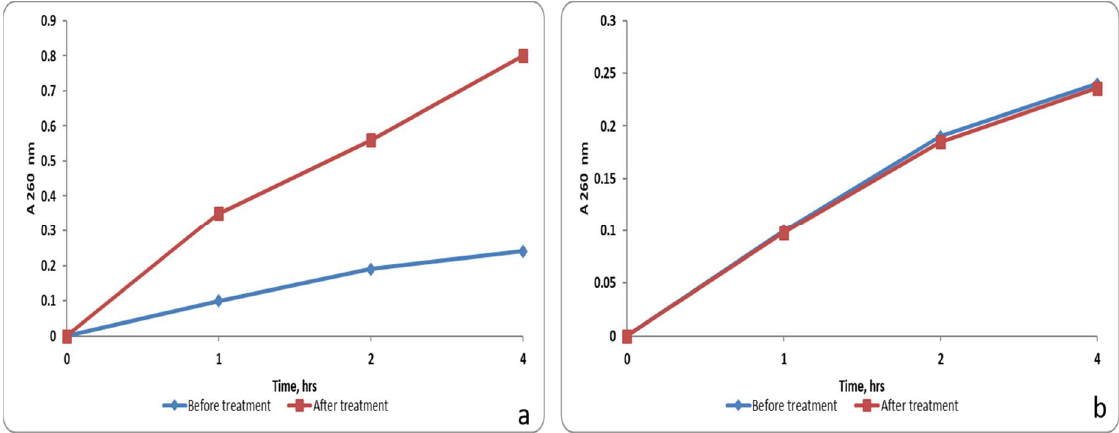
Figure 3. A graph showing the nucleic acid leakage from P. gingivalis isolates: ( a ) a significant increase in nucleic acid leakage after treatment with the frankincense extract (0.5 MIC); ( b ) non-significant change in nucleic acid leakage after treatment with 10%